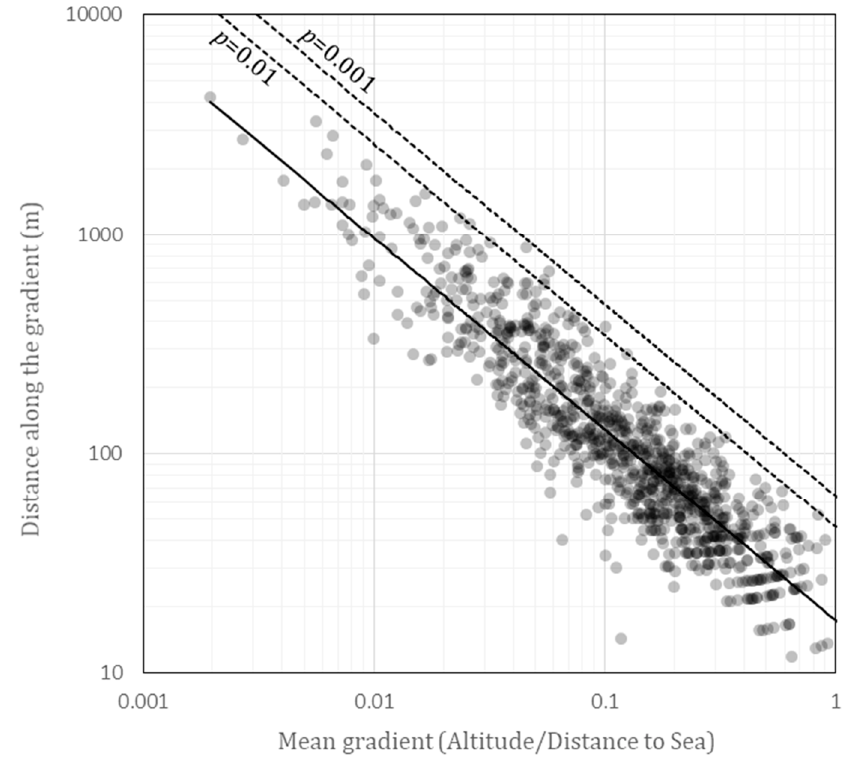
Figure A1. The empirical relationship between the mean gradient and the distance along the gradient for the highest Tsunami 2011 inundation and run-up for each drainage basin in the TTJS data [45]. The solid line is the mean and dashed lines are one-sided prediction interval of 99% and 99.9%.